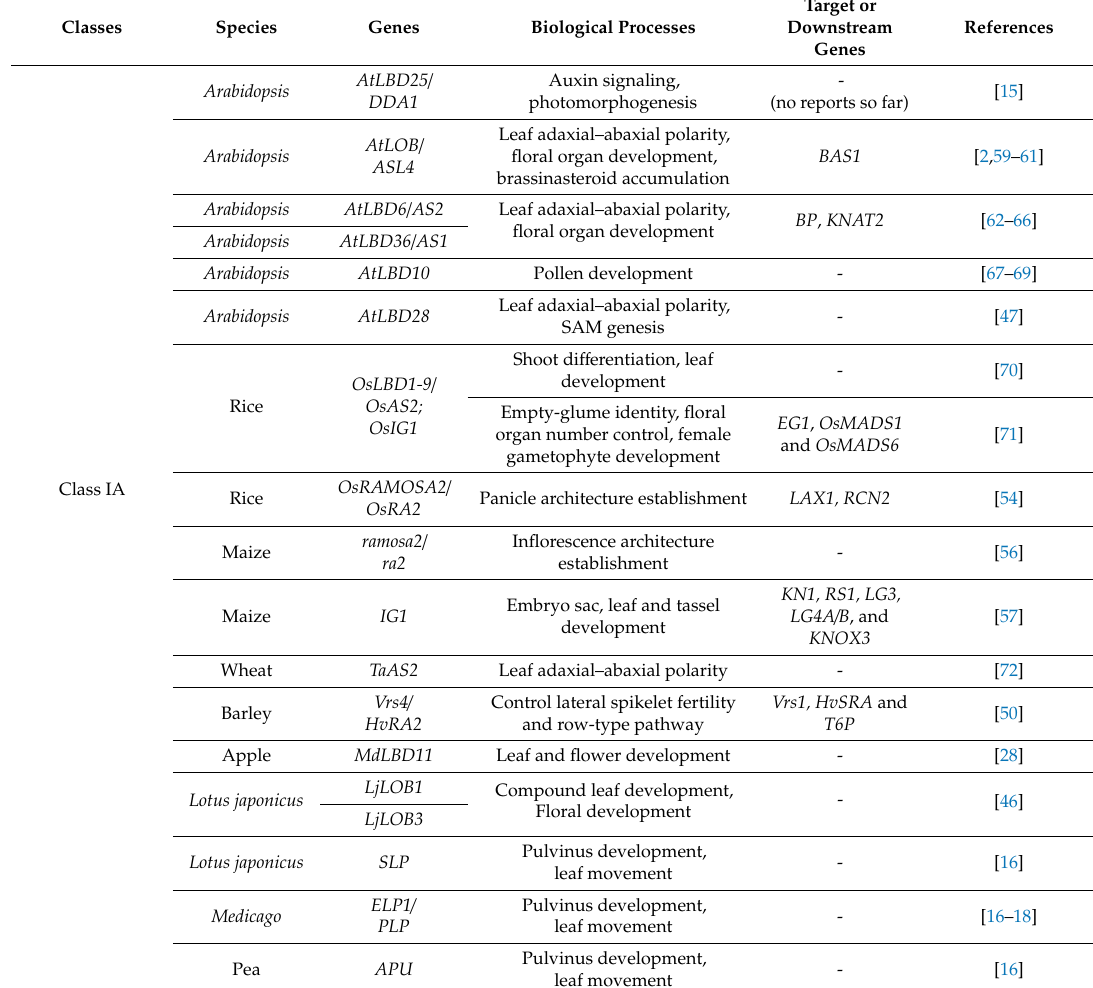
Table 2. Functionally characterized LBD genes and their phylogenetic classification. “-” means “no reports so